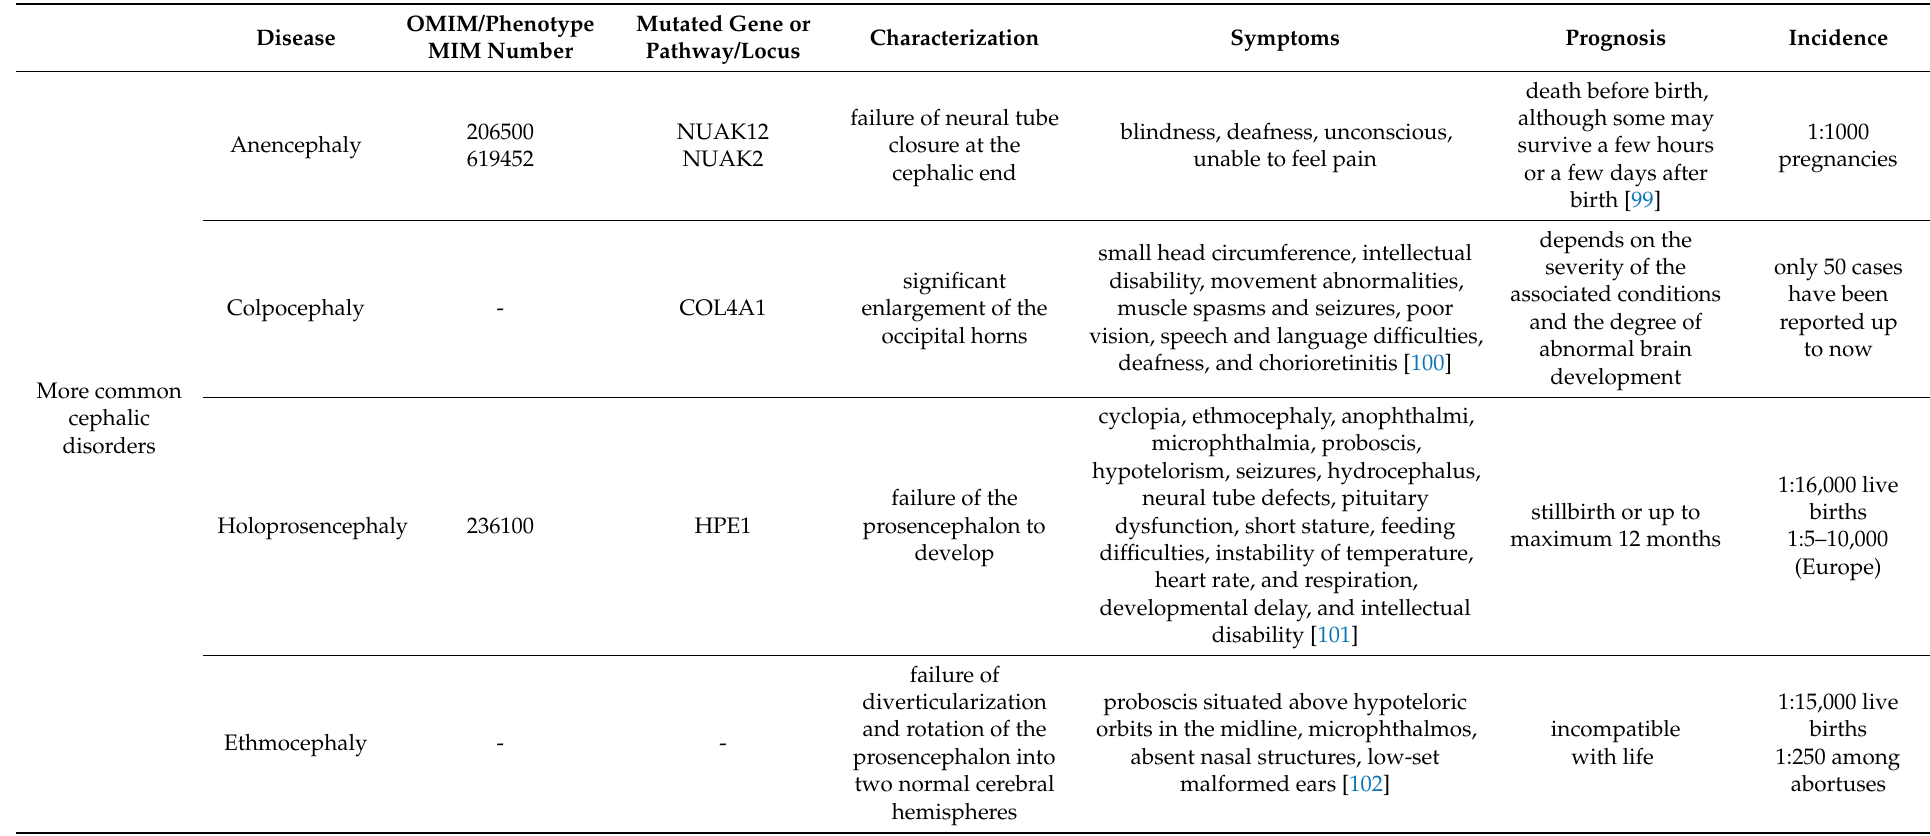
Table 1. Classification and characterization of cephalic